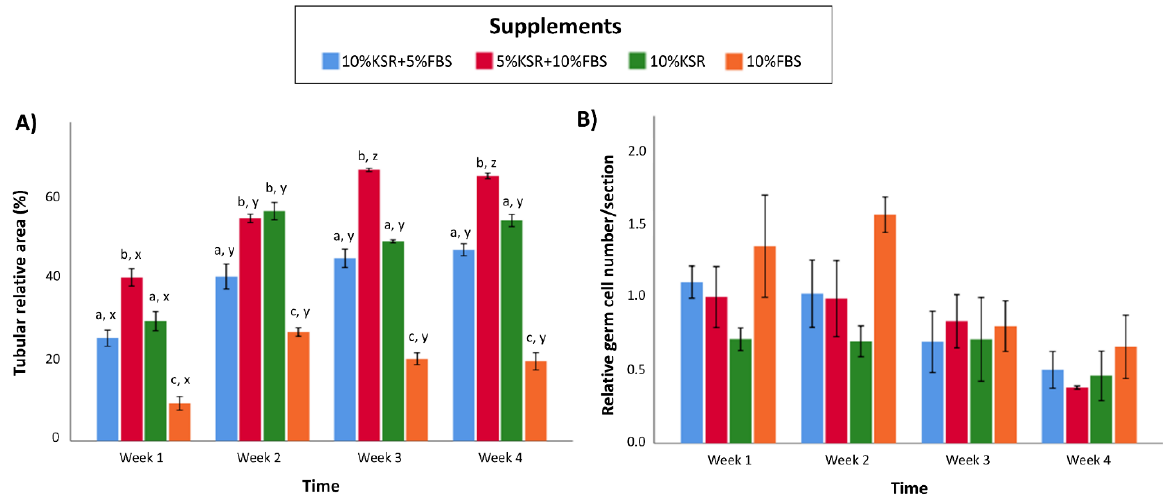
Figure 3. ( A ) Tubular relative area (% of cross-sectional tubular area compared with the total area of the histology section) and ( B ) relative germ cell numbers (% of germ cells to total number of cells in a histology cross-section) of testis organoids from different media supplementation groups over time. Data are presented as mean ± SEM. abc Data with different letters differ significantly among supplement groups ( p < 0.05). xyz Data with different letters differ significantly over time ( p < 0.05). n = 3 replications.